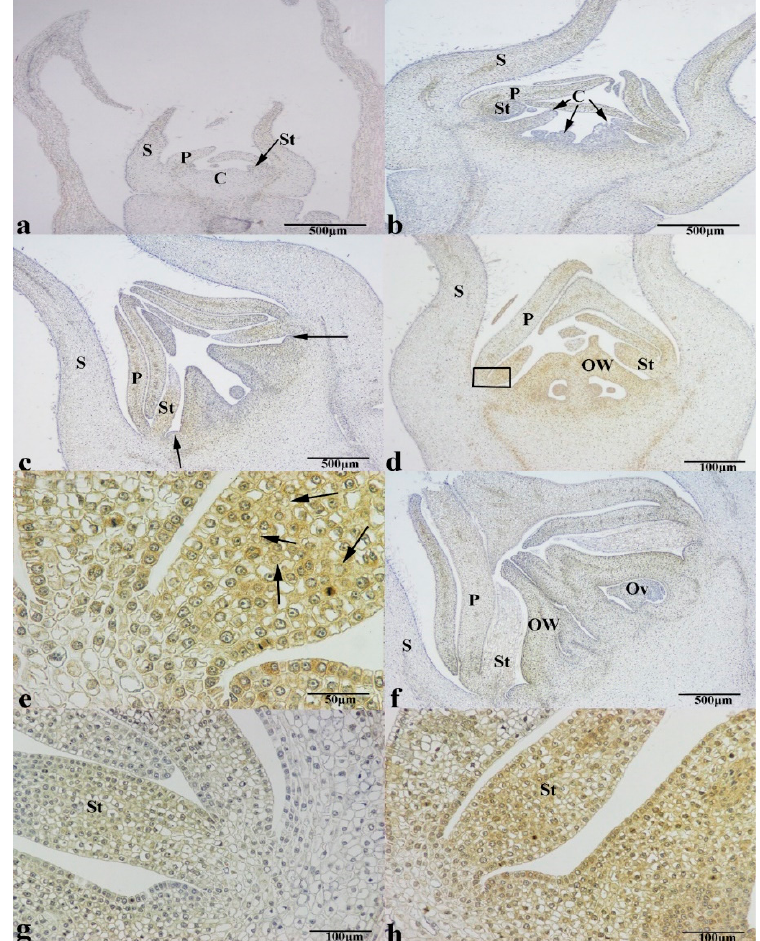
Figure 8. Cyt-c IHC expression of female floral buds during differentiation in persimmon. ( a ) No distinct cyt-c protein expression was observed during the carpel primordium differentiation stage in tissues harvested on April 5, 2017. ( b ) Weak cyt-c brown-staining signals occurred in the stamen primordium at the carpel primordium differentiation stage in tissues harvested on April 8, 2017. ( c ) Expression of the cyt-c protein at the ovule primordium differentiation stage (arrows indicate nectary tissues) in the stamen primordium harvested on April 11, 2017 was significantly greater. ( d ) Strong staining signals were clearly distinguishable in the stamen primordium in tissues harvested on April 14, 2017. ( e ) Image of the stamen primordium from the rectangle magnified in ( d ) (arrows indicate brown-stained dead cells). ( f ) Weak positive IHC signals for cyt-c expression were observed in tissues harvested on April 17, 2017. ( g ) Negative control of the stamen primordium in female flower buds harvested on April 14, 2017, where no distinct cyt-c staining signals was detected. ( h ) Stamen primordium in female flower buds harvested on April 14, 2017 (C = carpel; Ov = ovule; OW = ovary wall; P = petal; S = sepal; St = stamen).